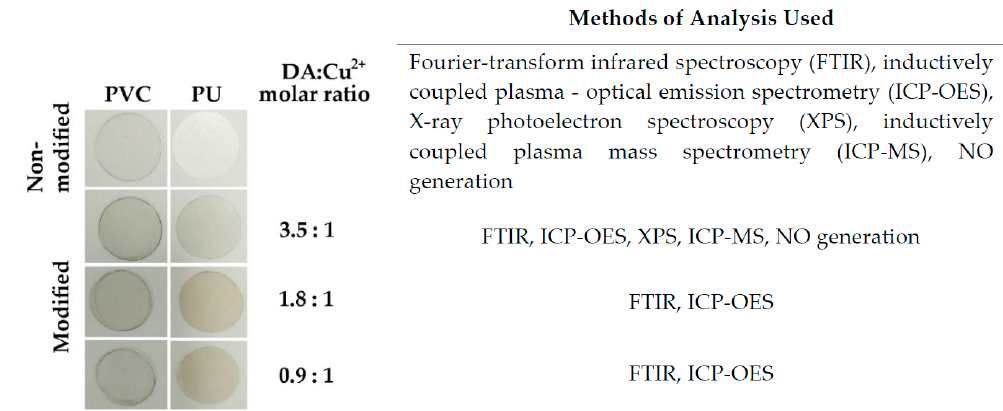
Figure 1. ( Left ) — Photographs of non-modified poly(vinyl chloride) (PVC) and polyurethane (PU) (upper row) and Cu-modified polymers (lower rows) obtained via incubation of polymers in in Tris- HCl buffer with different DA: Cu (cid:2870)(cid:2878) molar ratios; ( Right ) — methods of analysis used to determine buffer with different DA:Cu 2 + molar ratios; ( Right )—methods of analysis used to determine copper content and NO generation by the polymers.